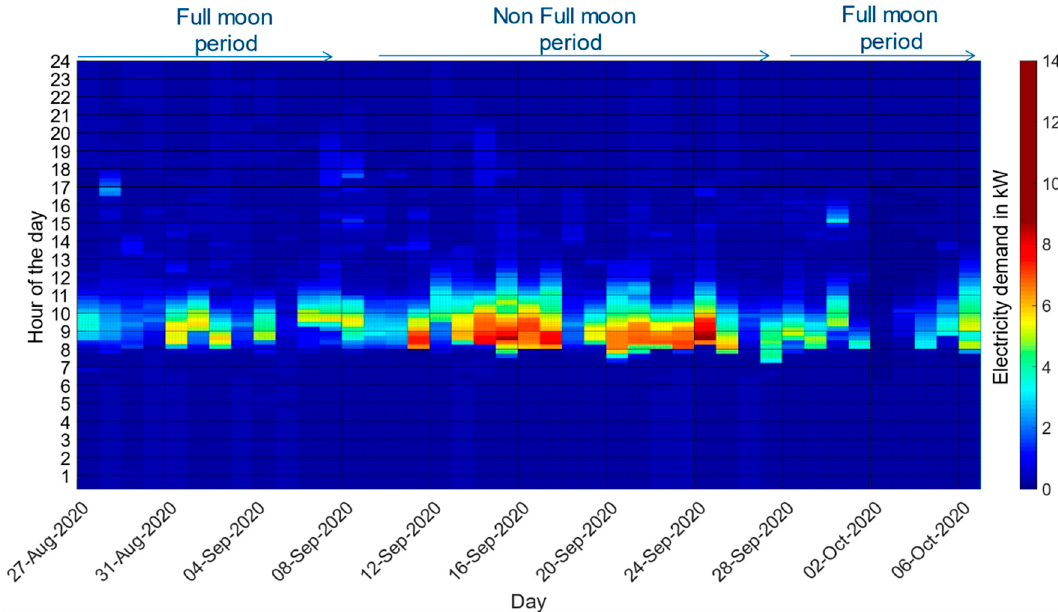
Figure 7 . Carpet plot of measured electricity consumption data from Mbita WeTu Hub during the normal operation period.